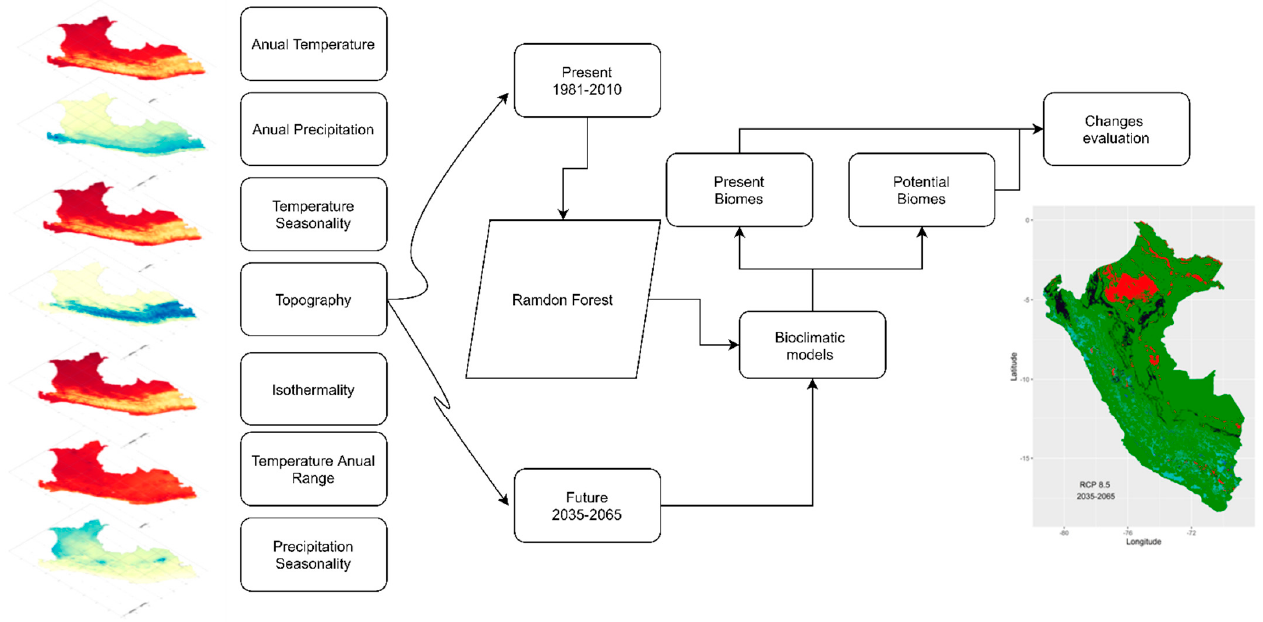
Figure 2. Workflow for the classification of biomes of Peru.